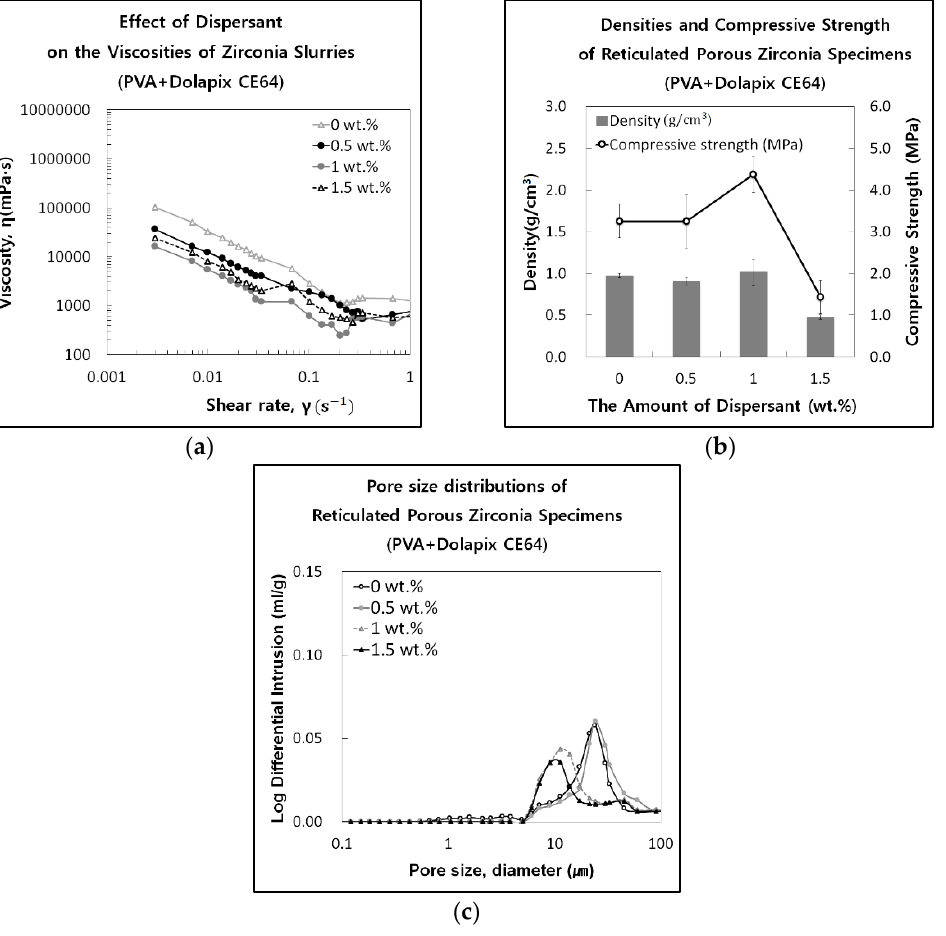
Figure 8. Effects of the addition of a dispersant (0 – 1.5wt.% Dolapix CE 64) on the ( a ) viscosities, ( b ) densities and compressive strength outcomes, and the ( c ) pore size distributions of reticulated porous zirconia specimens.